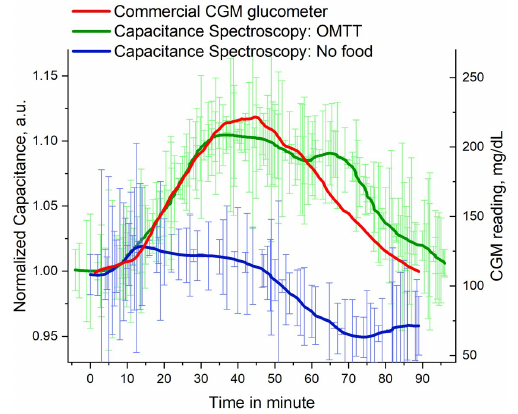
Figure 7. Capacitance spectroscopy of human finger in OMTT along with control reference and commercial CMG meter reading.